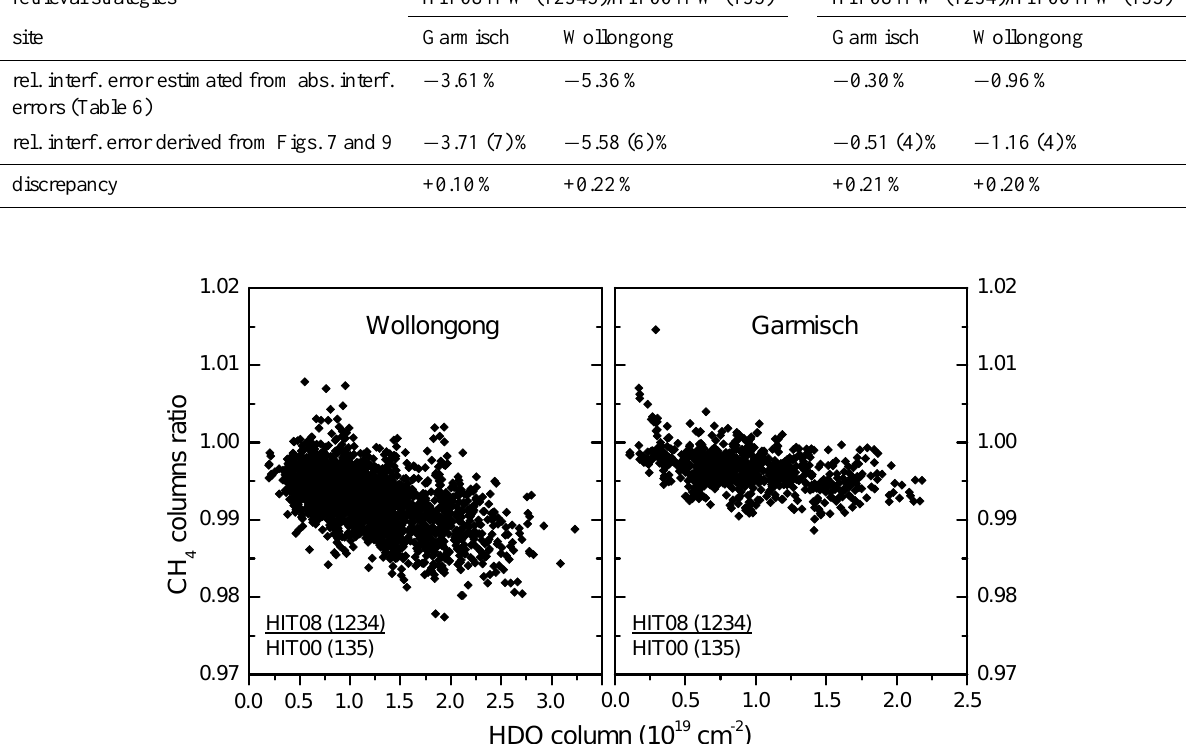
Table 7. Four validation cases using two independent ways of estimating relative interference errors. The discrepancy is a measure for the accuracy of the method of estimating absolute interference errors. For details see text. retrieval strategies HIT08 MW (12345)/HIT00 MW (135) HIT08 MW (1234)/HIT00 MW (135) site Garmisch Wollongong Garmisch Wollongong rel. interf. error estimated from abs. interf. − 3.61% − 5.36% − 0.30% − 0.96% errors (Table 6) rel. interf. error derived from Figs. 7 and 9 − 3.71 (7)% − 5.58 (6)% − 0.51 (4)% − 1.16 (4)% discrepancy +0.10% +0.22% +0.21%